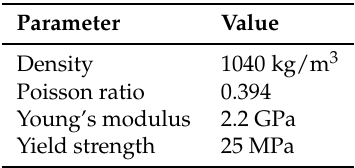
Table 1. Specifications of the material [37].